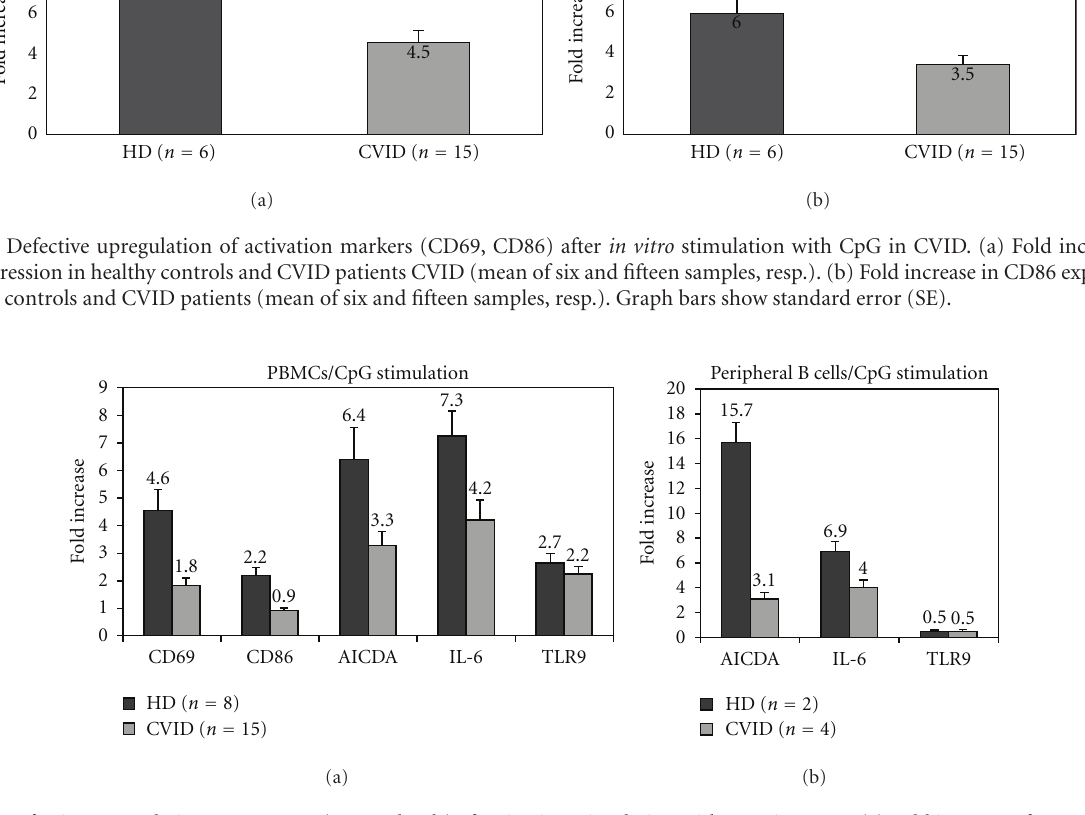
Figure 4: Defective upregulation target genes (mRNA levels) after in vitro stimulation with CpG in CVID. (a) Fold increase of CD69, CD86, TLR9, AICDA, and IL-6 at the mRNA level after CpG stimulation. Experiments were performed with PBMCs in triplicates for all patients ( n = 15) and healthy controls ( n = 8). (b) Fold increase of TLR9, AICDA, and IL-6 at the mRNA level after CpG stimulation. Experiments were performed with purified B cells from patients ( n = 4) and healthy controls ( n = 2). Graph bars show standard error